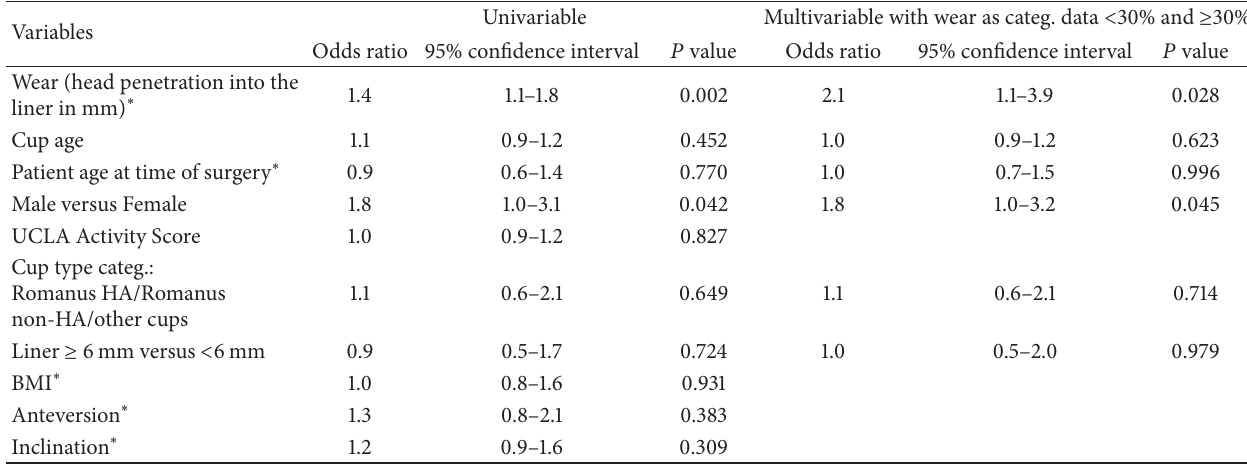
Table 4: Periacetabular osteolysis as outcome-proportional odds model.